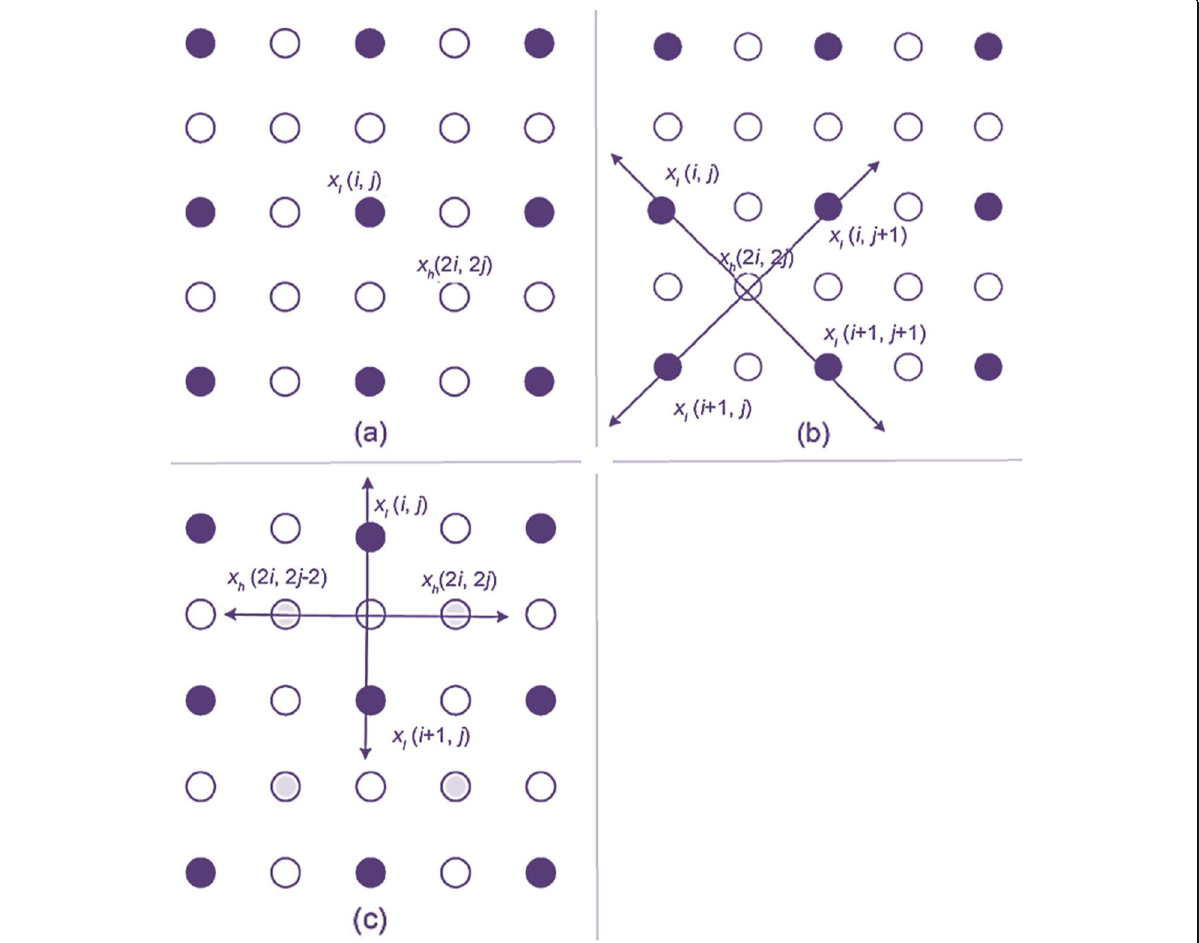
Fig. 2 The steps in estimating non-existing pixels [18]. a Original and non-existing pixels. b , c Computing of estimated values of 75% non-existent pixels in different directions. After doing these three steps, all the non-existing pixels will be